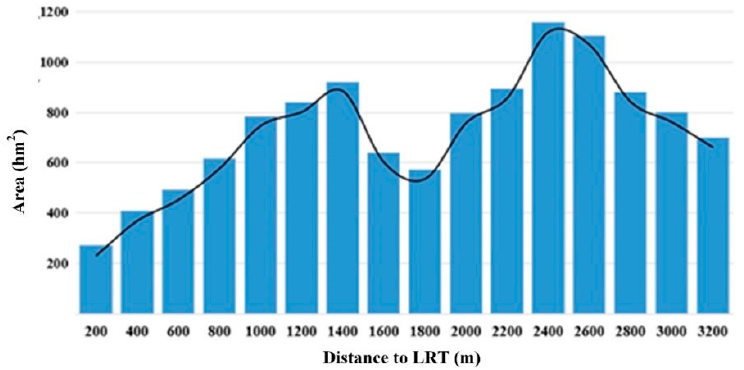
Figure 5. Absolute area change of LUC (farmland to construction) near the LRT line with various distances.